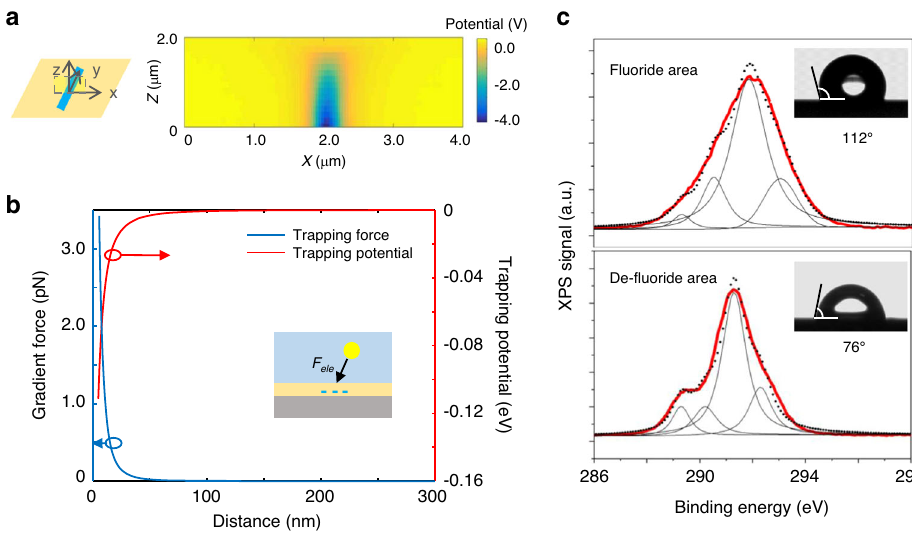
Fig. 3 Quantitative analysis of NP – substrate interactions. a Electrostatic potential distribution along the x-z plane induced by a charged line with 10 μ m length (y axis) and 50 nm width ( x axis), which is written by applying a voltage of -90 V on the substrate. The electric fi eld is highly localized in the vicinity of the charge line, inducing strong attraction to the surrounding NPs. b The calculated electrostatic force and potential of the 1D charged pattern to NPs in a nonpolar solvent, based on the measured potential distribution ( a ). Inset is the schematic illustration of the electrostatic attraction force between the charged pattern and dispersed NPs. c XPS spectral analysis of carbon 1 s on charged (de- fl uorinated) and uncharged ( fl uoride) area. The original spectra are shown by the black dotted curve, which is well fi tted by the sum (red solid curves) of four Gaussian lines (solid black curves). The high voltage leads to a decrease in the peak at 290.5 and 291.8 eV, which can be assigned as di fl uoride carbons, and an increase in the peak at 289.3 and 293.0eV, which can be assigned as the carboxylation carbons. Insets are the corresponding water contact angle of fl uoride and de- fl uoride area, decreasing from 112 o to 76 o